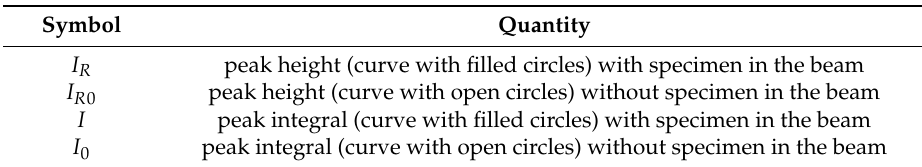
Figure 2. Rocking curves measured at one detector pixel and normalized to the peak maximum. Open circles: Without specimen (FWHM = 0.00034°); and filled circles: With specimen (FWHM = 0.00062°). Table 1. The rocking curve parameter used to calculate the attenuation properties and the relative specific refraction value of the specimens.